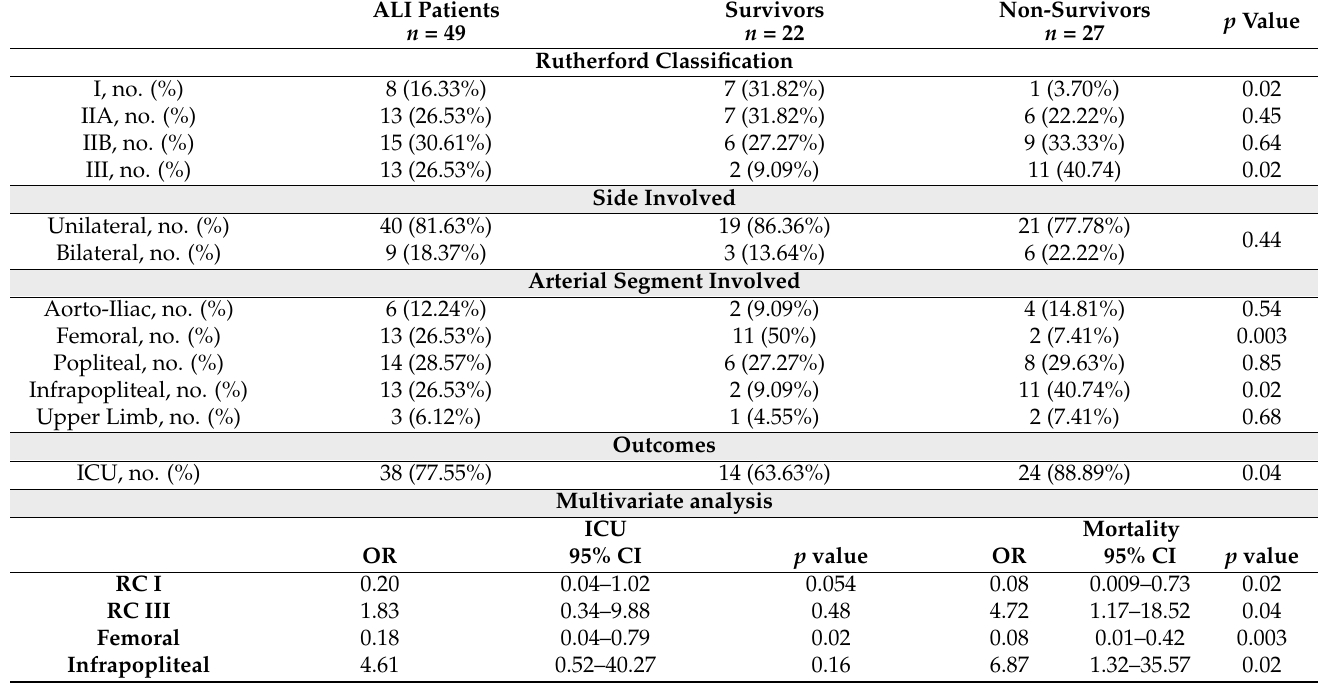
Table 6. Characteristics of ALI patients and multivariate analysis of new adverse